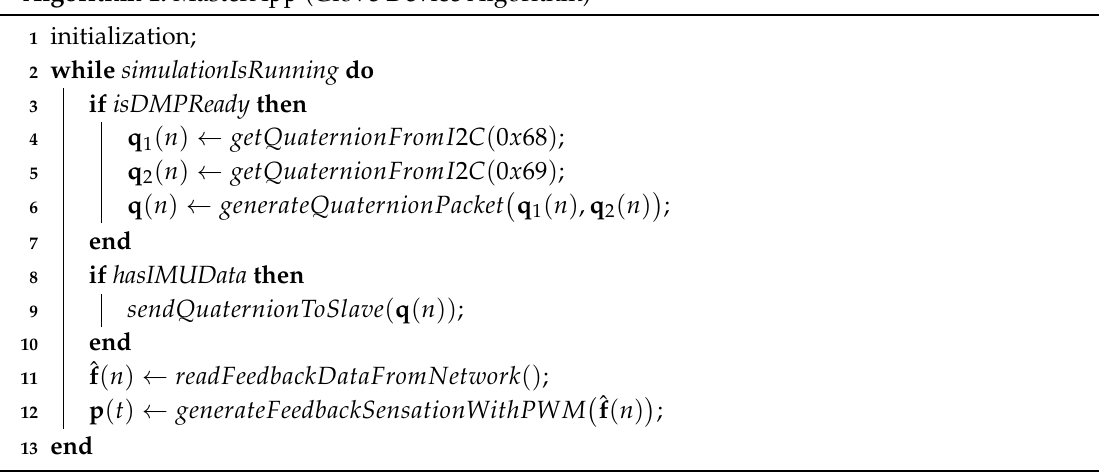
Algorithm 1: MasterApp (Glove Device Algorithm)